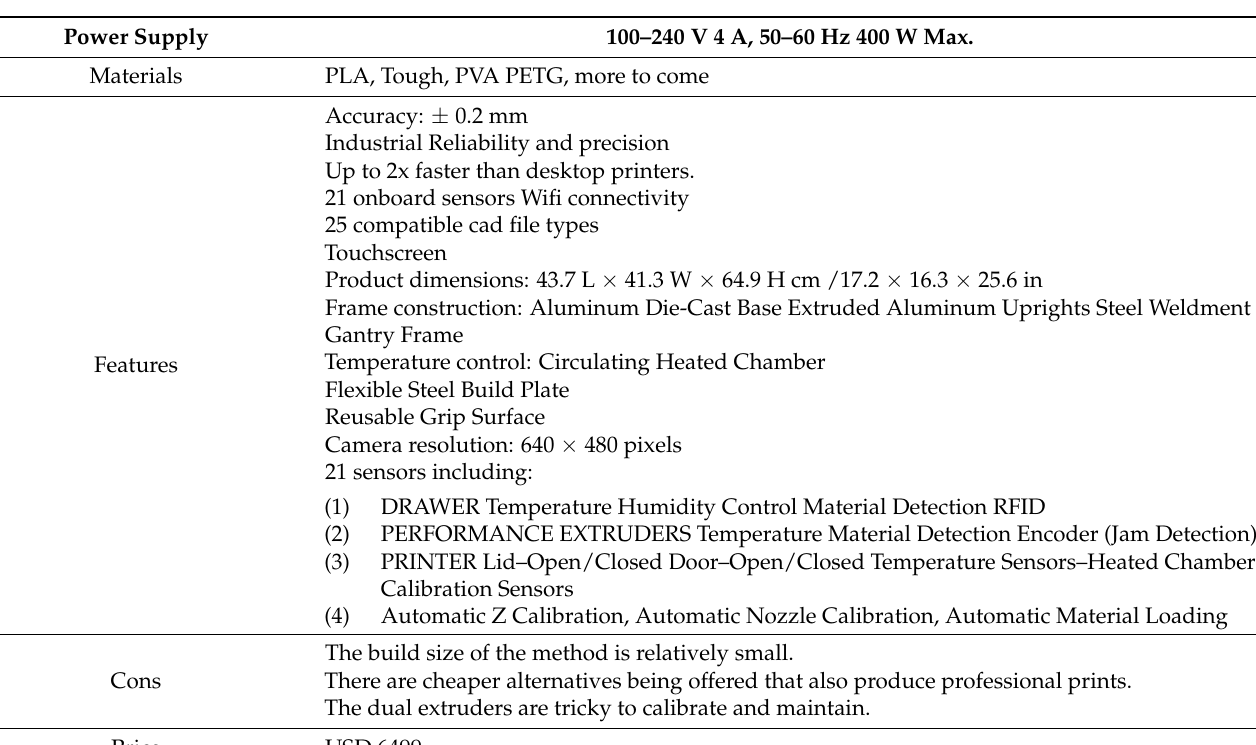
Table 7. Descriptions of Makerbot Method Desktop 3D